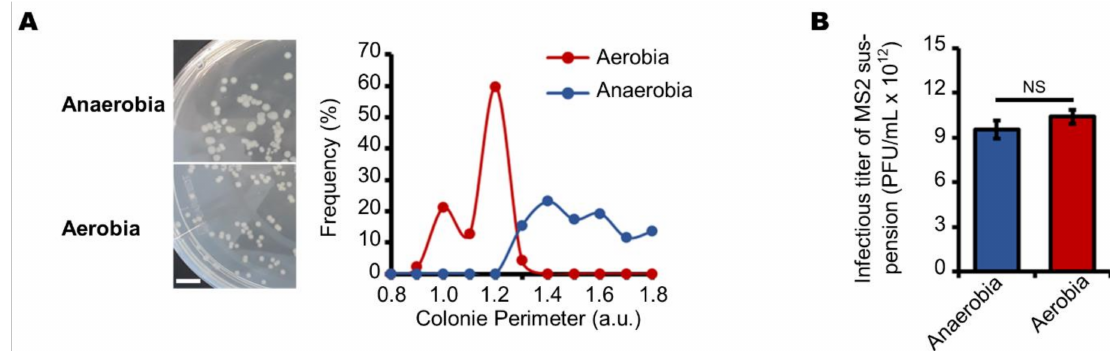
Figure 1. Aerobic and anaerobic culture conditions affect E. coli growth without changing its susceptibility to MS2 phage infection. ( A ) E. coli colonies grown under anaerobic conditions are larger than those grown under aerobic conditions. The left panels show pictures of E. coli colonies grown on double layer agarose plates under anaerobic and aerobic conditions for 18 h at 37 ◦ C (scale bar corresponds to 1.0 cm). The data displayed in the right panel show the circumference distribution of 50 E. coli colonies, cultured under anaerobic (blue) and aerobic conditions (red) (“a.u.” stands for arbitrary unit). ( B ) the same MS2 suspension induced the formation of similar numbers of plaques when cultured on a lawn of E. coli under anaerobic and aerobic conditions. In all panels, the data are representative of experiments carried out on separate days (( A ): n = 2; ( B ): n = 3). Error bars indicate standard errors. “NS” stands for statistically non-significant: p > 0.05, the statistical tests are described in the Materials and Methods